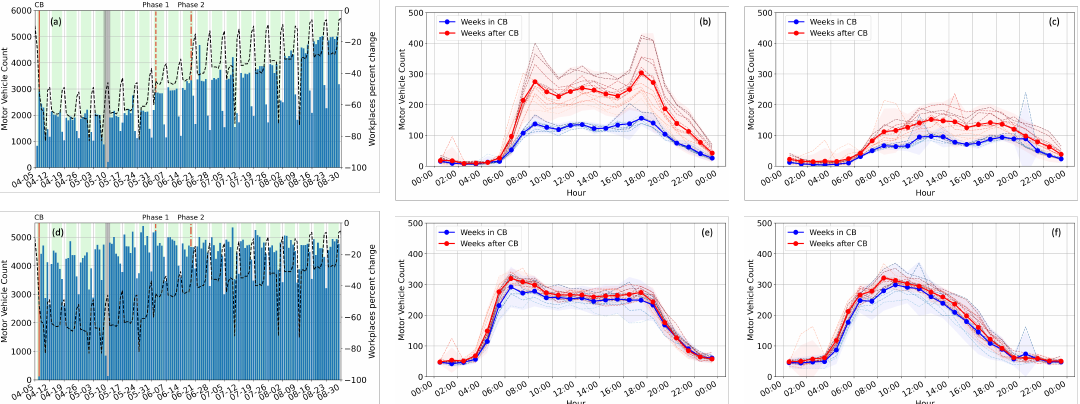
Figure 7. Daily and hourly motor vehicle statistics observed at the NUS exit ( top row ) and the Pasir Panjang Terminal Port ( bottom row ). In ( a , d ), the black dashed line denotes the percentage change at workplaces from the Google Mobility Report, while the blue bars denote the daily vehicle count derived from our data. In ( b , c , e , f ), vehicle counts derived from seismic data are plotted with blue and red colors to denote the periods during and after the lockdown, respectively. In ( b , e ), hourly motor vehicle counts are shown for the weekdays. In ( c , f ), hourly motor vehicle counts are shown for the weekends. In ( b , c , e , f ), the thick solid lines denote the average vehicle count over all the weeks during (blue) and after (red) the lockdown and the thin dashed lines denote the weekly averages. The darker dashed line denotes a later week compared to a lighter dashed line. The shaded area covers the range of twice the standard deviations above and below the